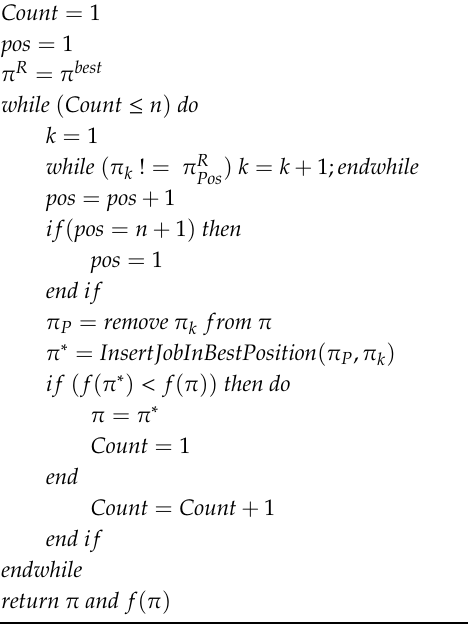
algorithm is coded in C ++ programming language on Microsoft Visual Studio 2013, and a full